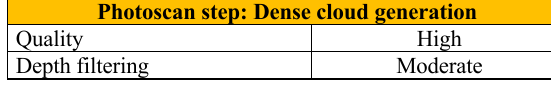
Table 6. Dense cloud generation settings for all datasets.